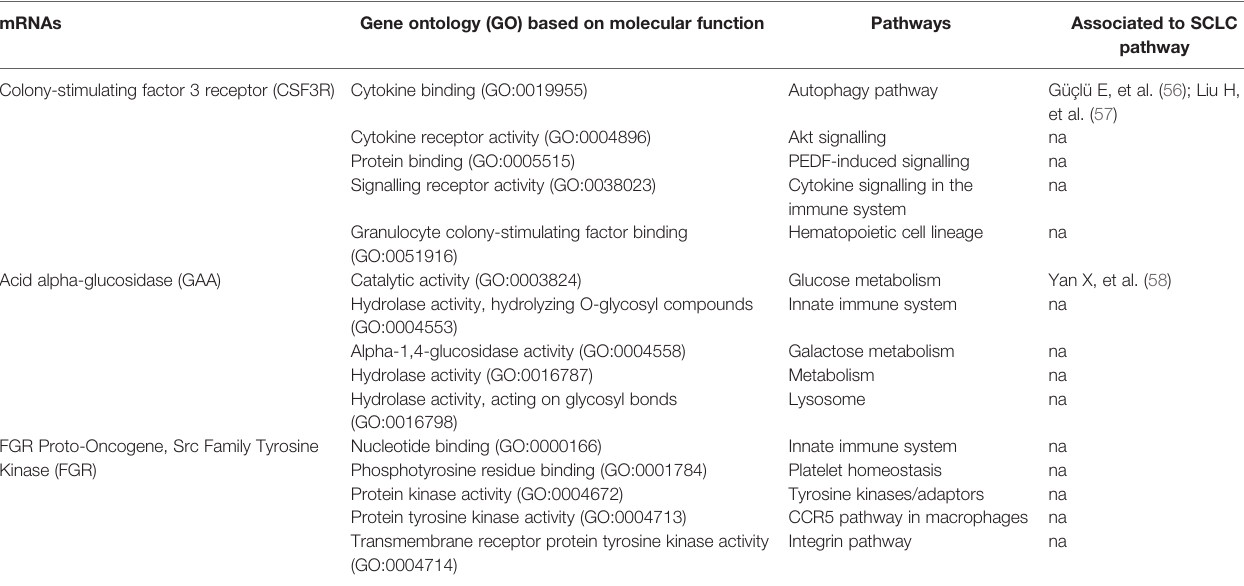
TABLE 9 | Pathways of mRNAs in the ceRNA networks in SCLC. mRNAs Gene ontology (GO) based on molecular function Pathways Associated to SCLC